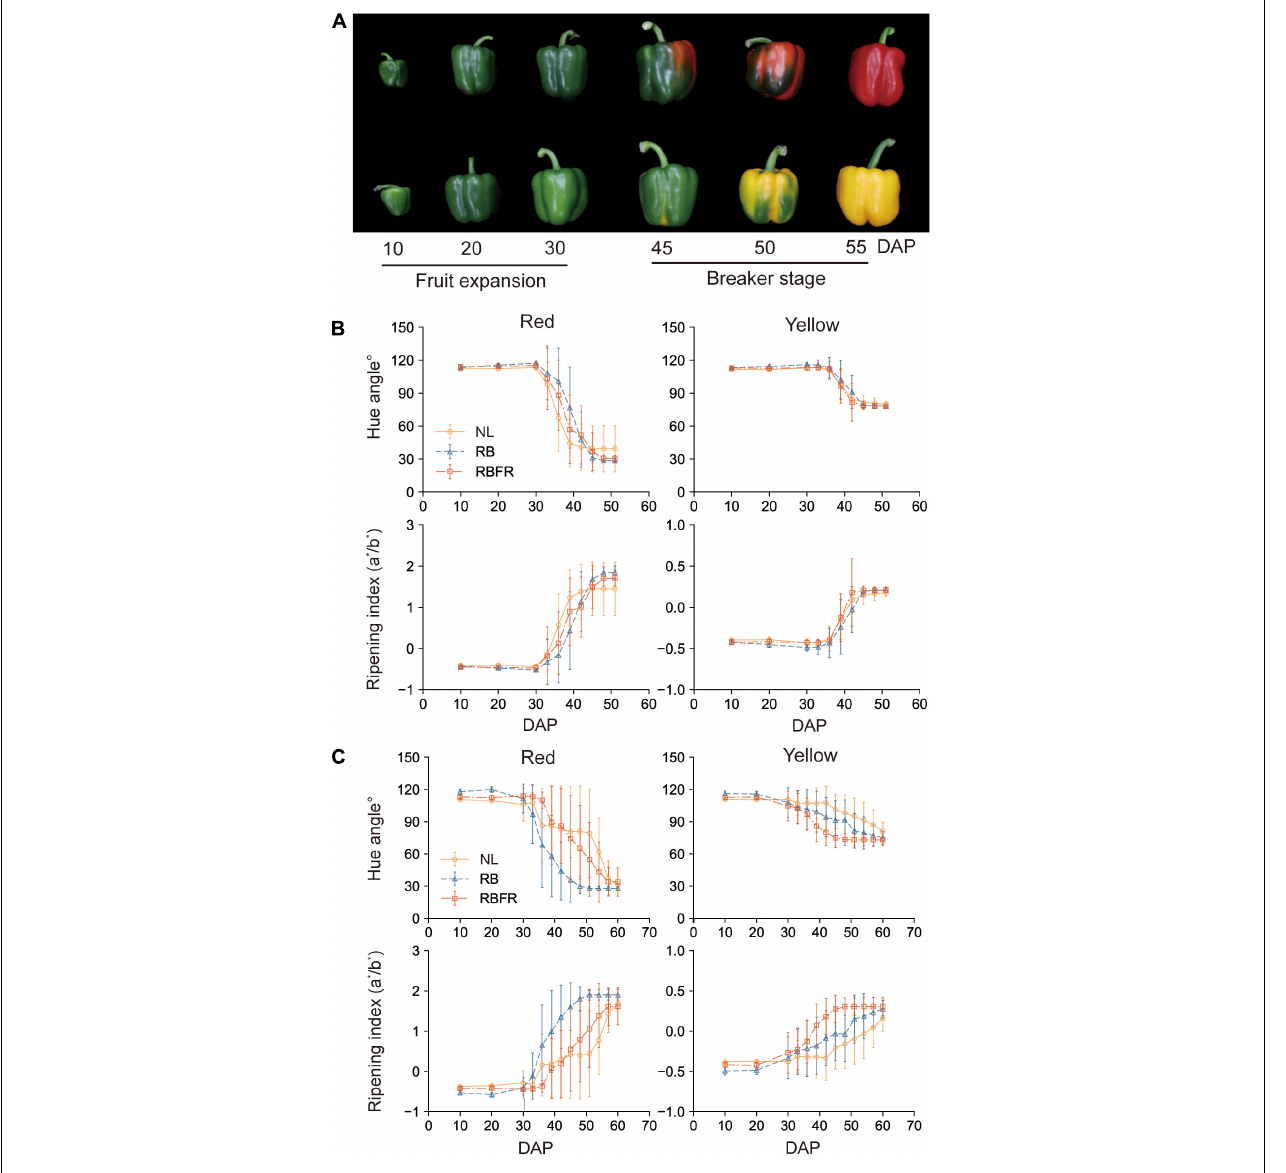
FIGURE 4 | Fruit coloration of red and yellow fruits of sweet peppers grown under natural light (NL), NL with red + blue LED interlighting (RB), and RB with far-red light (RBFR), respectively. Developmental process of sampled fruits (A) , hue angles, and ripening index of red and yellow fruits according to DAP in Groups 1 (B) and 2 (C) . The hue angles and ripening indices were calculated from the measured L*, a*, and b* values. Hue angle was calculated with 180 + tan − 1 (b*/a*). Groups 1 and 2 indicate fruits sampled at different harvesting periods as shown in Figure 1 . Values are the mean ± standard deviation ( ± SD) of 30